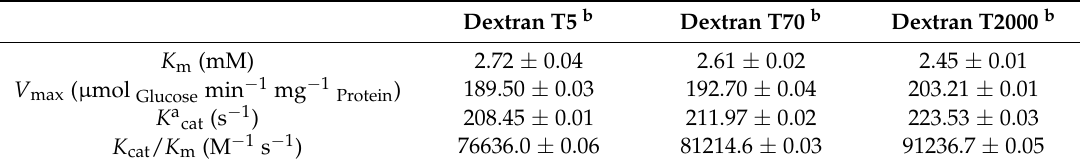
Table 4. Kinetic constants of purified dextranase from Penicillium cyclopium.